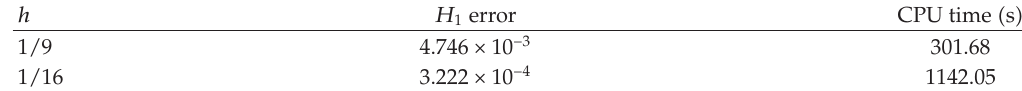
Table 1: H 1 error and CPU time of the finite element method.